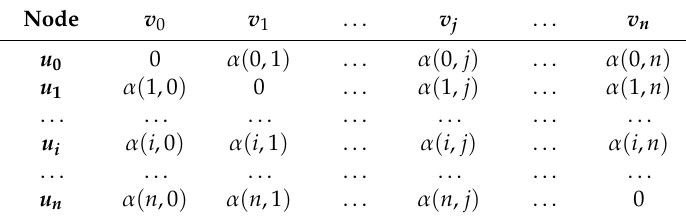
Table 1. Propagation Time Initialization